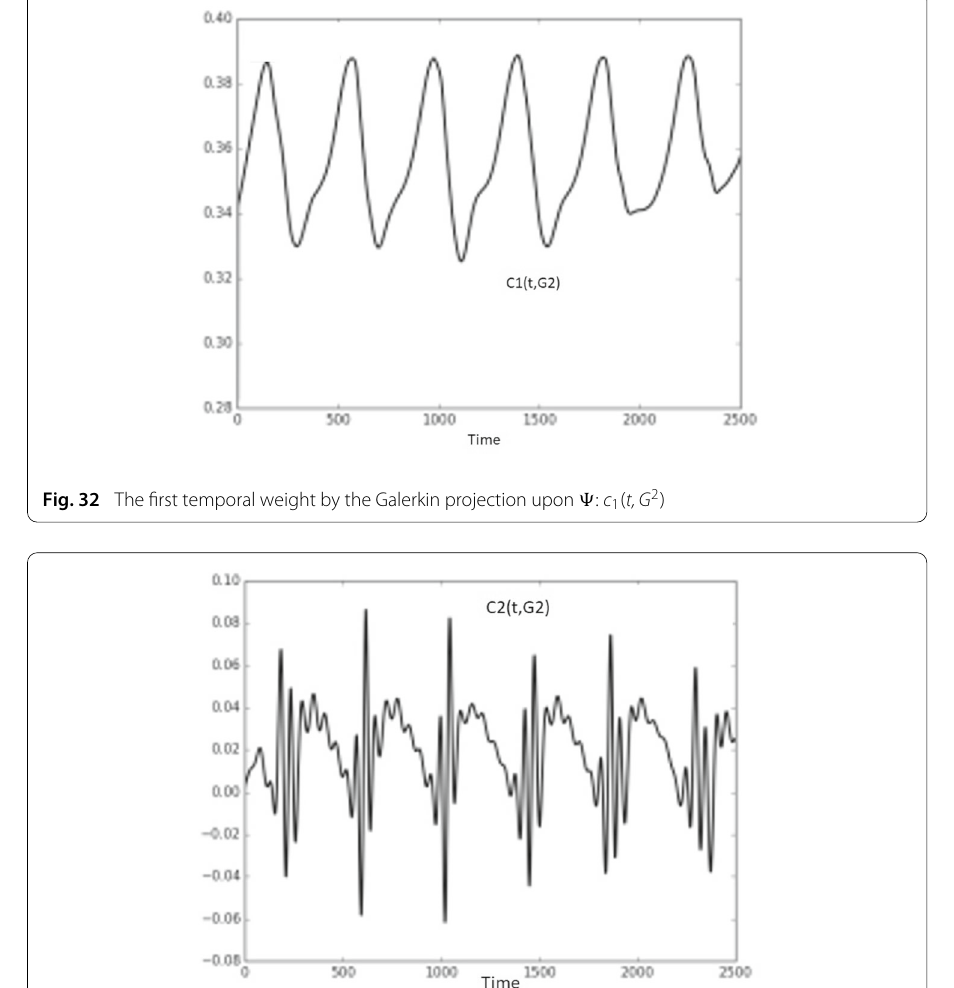
bythistechnique.Thesefieldsarecomparedwiththecorrespondinghighfidelitymeanand root mean square components with configuration 1 and with the nominal